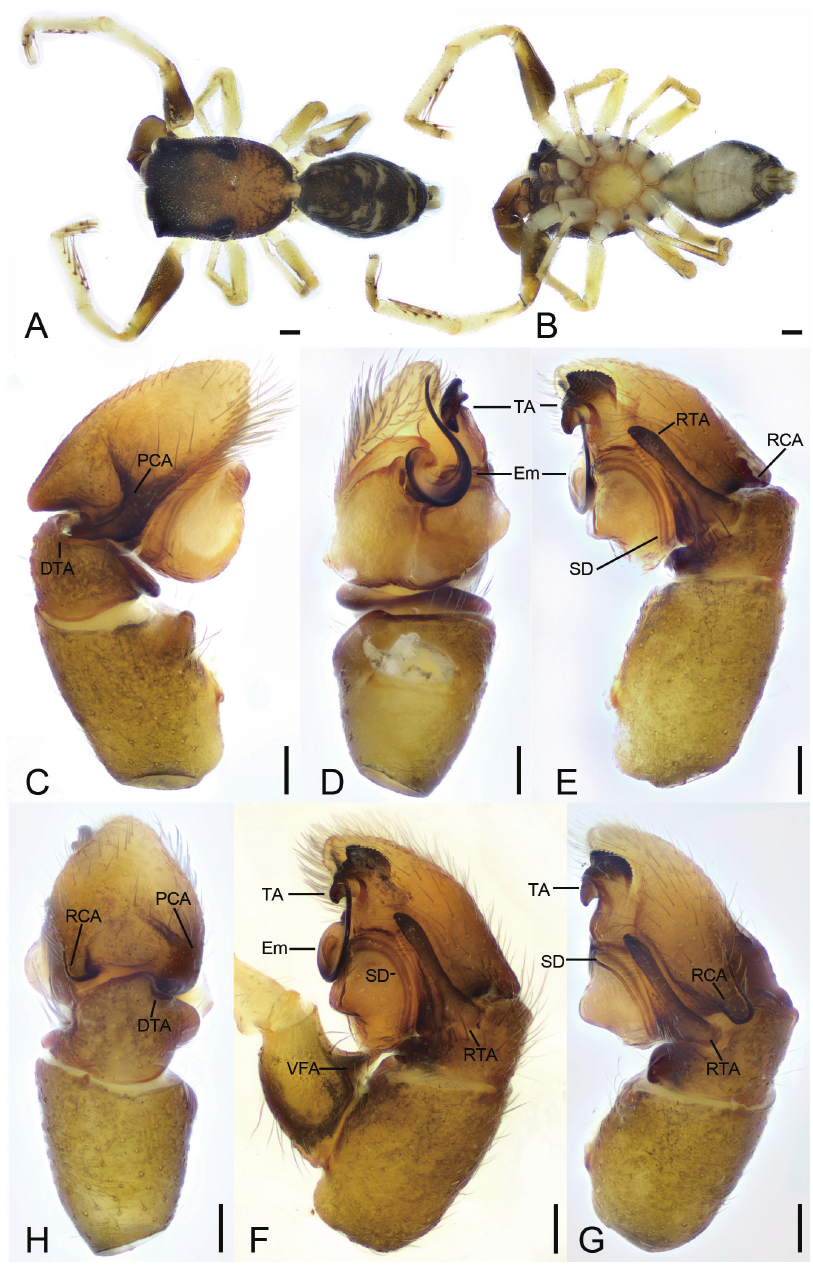
Figure 4. Synagelides jinding sp. nov., holotype male A habitus, dorsal view B same, ventral view C palp, pro- lateral view D same, ventral view E same, retrolateral view F same, detail of ventral femoral apophysis, retrolat- eral view G same, retrolateral view, slightly dorsal H same, dorsal view. Abbreviations: DTA – dorso-prolateral tibial apophysis, Em – embolus, PCA – postero-prolateral cymbial apophysis, RCA – postero-retrolateral cym- bial apophysis, RTA – retrolateral tibial apophysis, SD – sperm duct, SS – scale-like serrations, TA – terminal apophysis, VFA – ventral femoral apophysis. Scale bars: 0.2 mm ( A, B ); 0.05 mm ( C–E, G, H ); 0.1 mm ( F